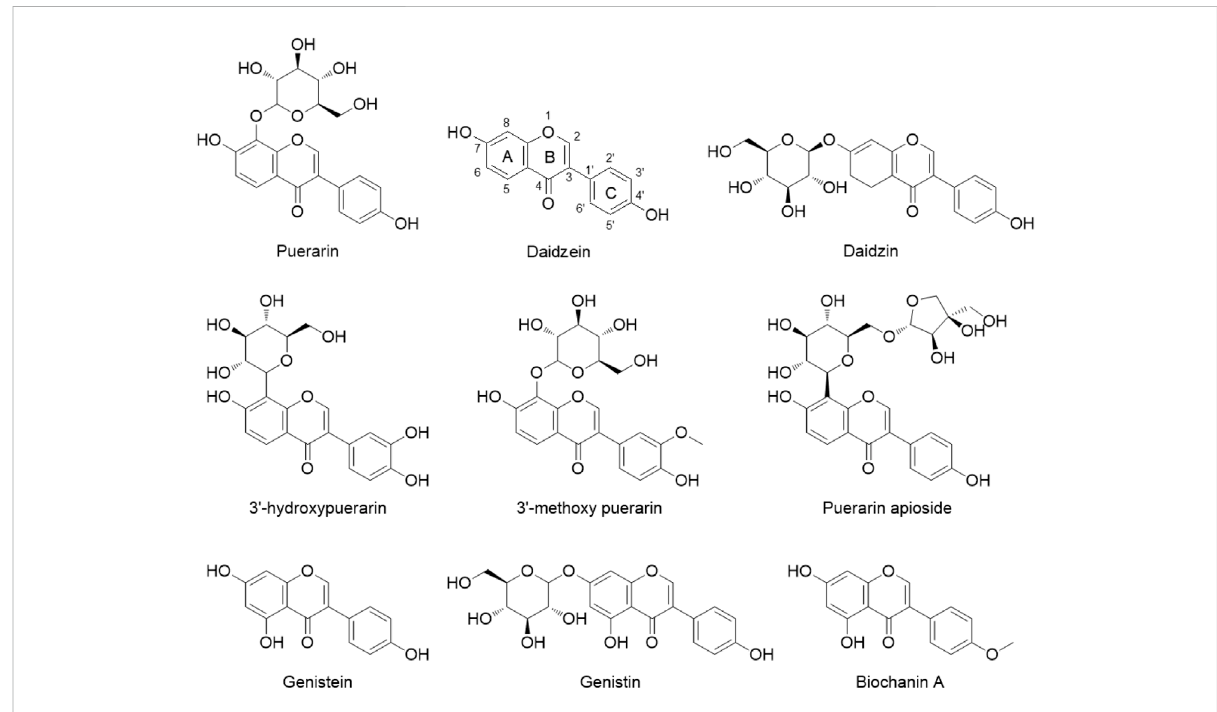
FIGURE 1 Structures of the major components in Gegen water